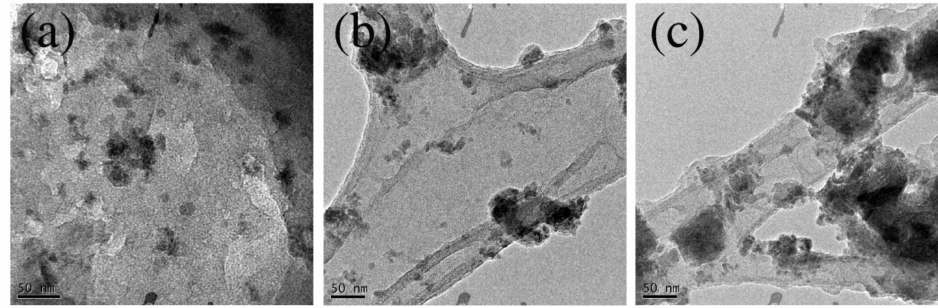
Figure 4. TEM images of 25 GQD IPA -EDA ( a ), 200 GQD-5EDA ( b ), and 200 GQD-10EDA ( c